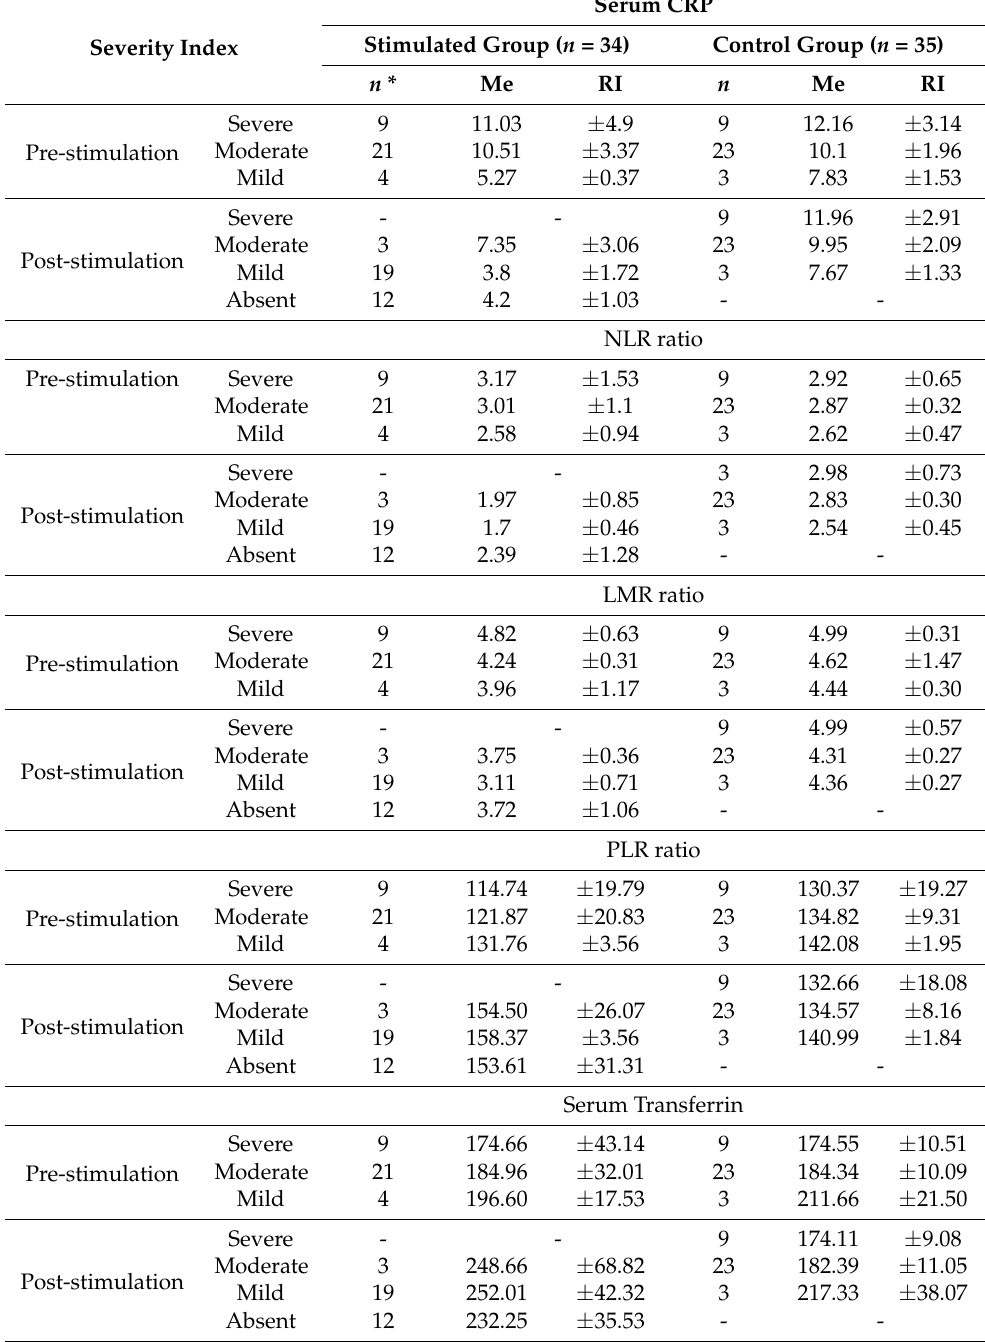
Table 2. Inflammatory markers according to endoscopic + histological severity index before and after